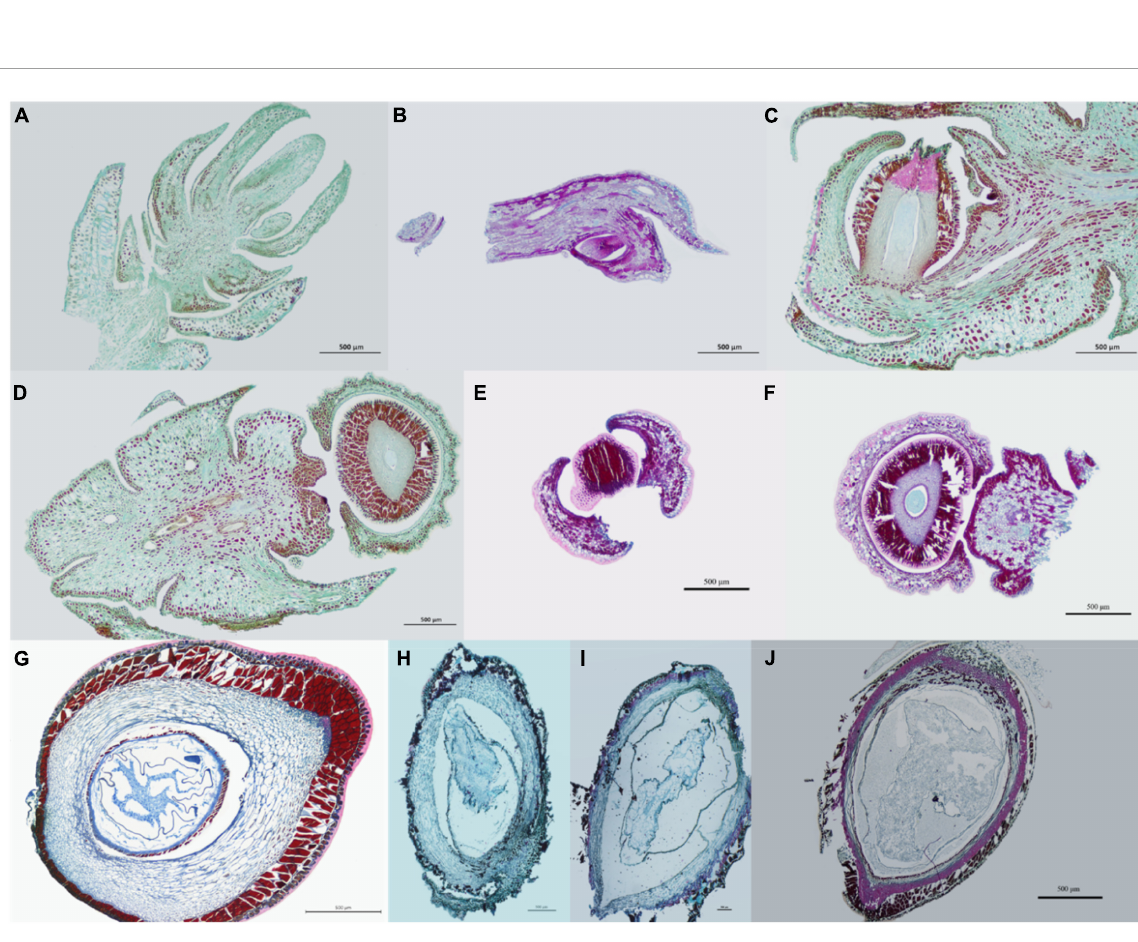
FIGURE3 Microscopic images of female cones of Dacrydium pectinatum at different developmental stages. (A,B) Flower bud differentiation stage. ( A : January.25.2019; B : February.25.2019); (C–E) Bract primordium differentiation stage. ( C : March.25.2019; D : April.25.2019; E : May.10.2019); (F–H) Ovule development and maturation stage. ( F : June.25.2019; G : July.25.2020; H : August.25.2020); (I,J) Seed maturation stage. ( I : September.25.2020; J :